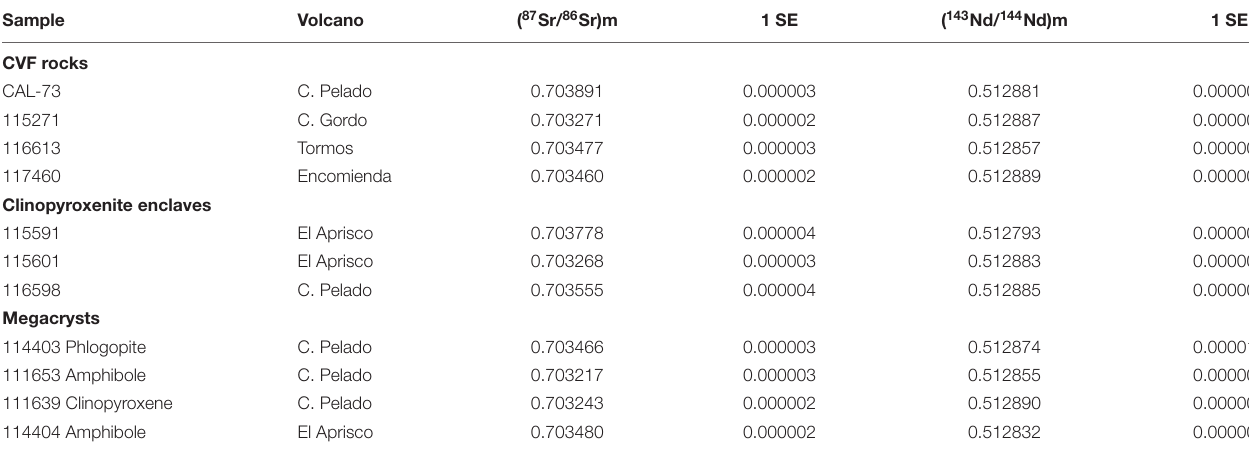
TABLE 2 | Isotopic (Sr, Nd) composition of the Calatrava Volcanic Field (CVF) rocks and associated megacrysts. Sample